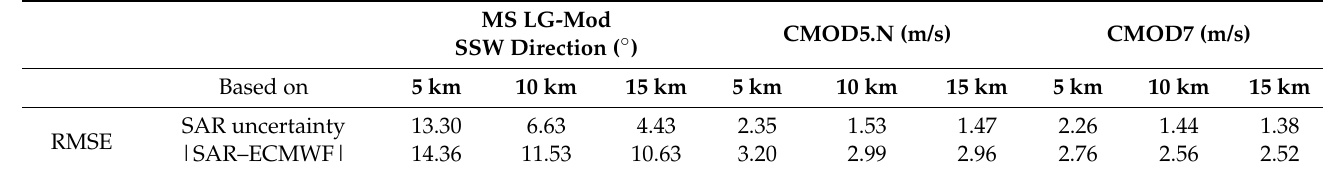
Table 4. Comparison of Root Mean Square Error (RMSE): “SAR uncertainty” values derive from SAR SSW direction ( ◦ ) and speed (m/s) uncertainty ( ∆ ϕ and ∆ W max , respectively); “|SAR-ECMWF|” values refer to the difference between the SAR SSW direction and speed estimates and the ECMWF ones (( ϕ - ϕ ECMWF ) and (W-W ECMWF ), respectively). Statistics obtained for all ROIs, at various dimensions. Two different GMFs applied for wind speed retrievals.